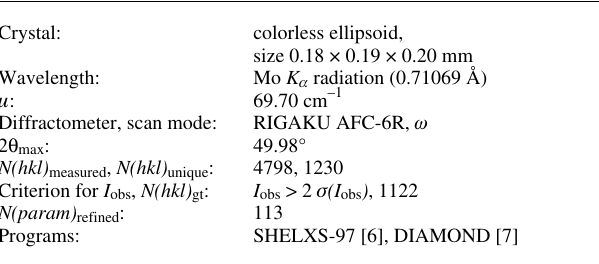
Table 16. Data collection and handling. Table 17. Atomic coordinates and displacement parameters (in Å 2 ) .